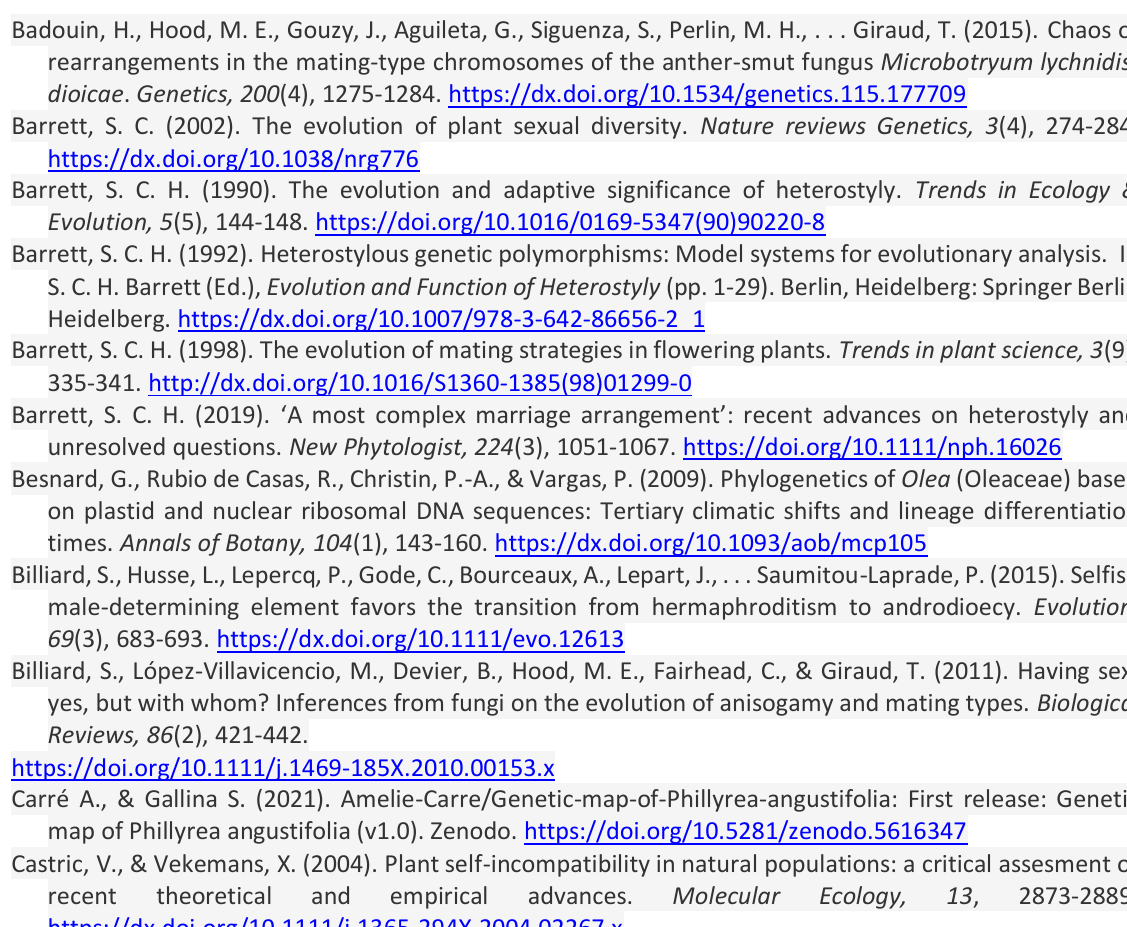
Figure S1. Phillyrea angustifolia sex-averaged linkage map showing the grouping and position of 15812 SNPs. Figure S2. Comparison between the maternal and paternal genetic maps. Table S1. List of the 82 gene annotations in the chromosomal interval of the olive tree genome bounded by P. angustifolia loci strictly associated with sex. Table S2. List of the 32 gene annotations in the chromosomal interval of the olive tree genome bounded by P. angustifolia loci strictly associated with